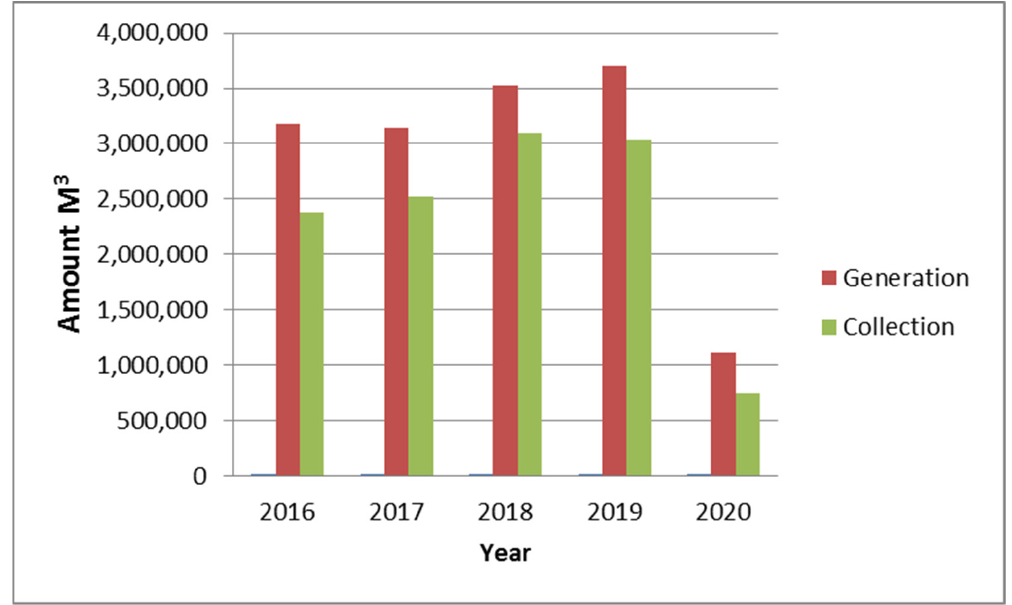
Figure 3. Generated and collected solid waste in Addis Ababa during 2016–2020 in M 3 (Sources: AASWMA